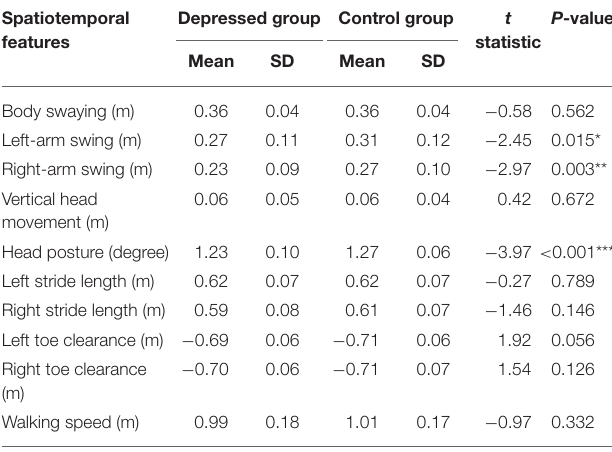
TABLE 2 | Differences of spatiotemporal features between depressed group and control